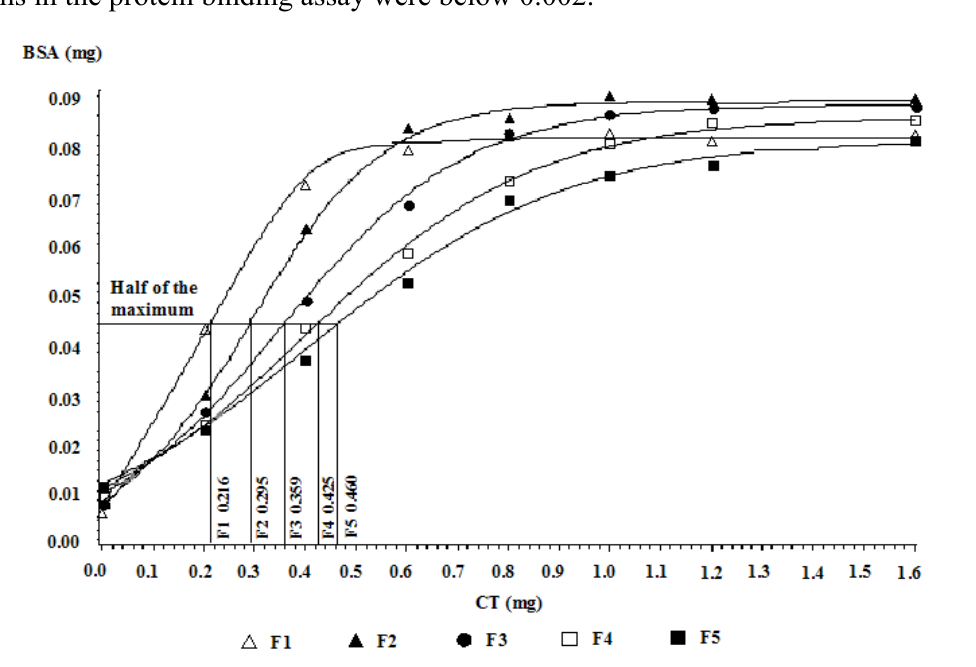
Figure 5. Protein-binding affinities of CT fractions of different molecular weights from LLR. The Y-axis represents the bonded bovine serum albumin (BSA) values, and the X-axis represents different CT amounts. The standard deviations (SD) for all the CT fractions in the protein binding assay were below 0.002.